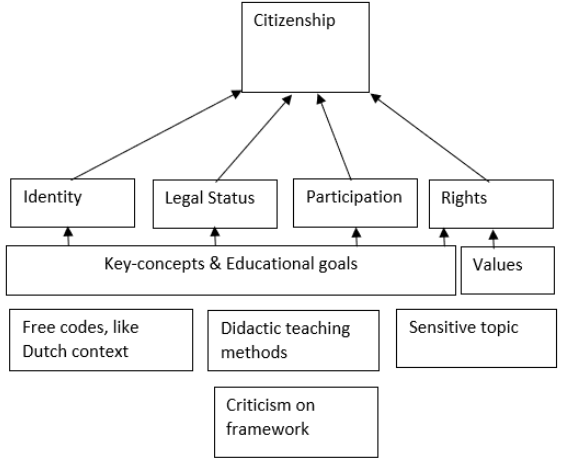
Scheme 1. Atlas.ti code